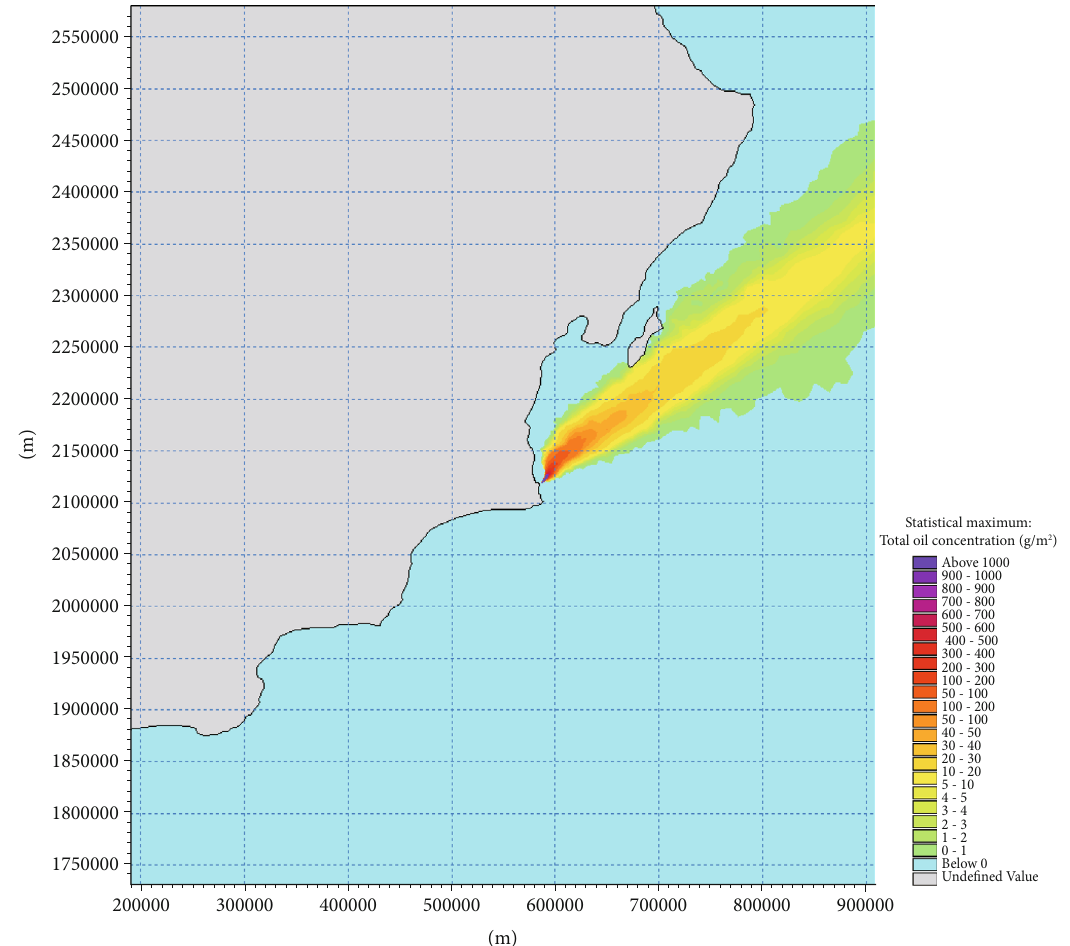
Figure 14: Map of maximum oil concentration for scenario 1 (sub-surface blowout: 16,000 m 3 spill at SPM1) (under typical wind in the summer